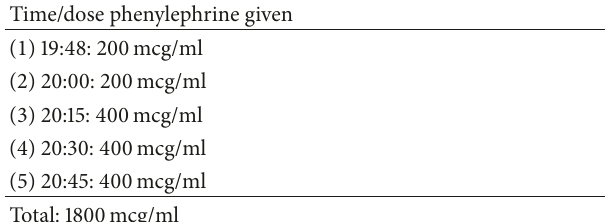
Time/dose phenylephrine